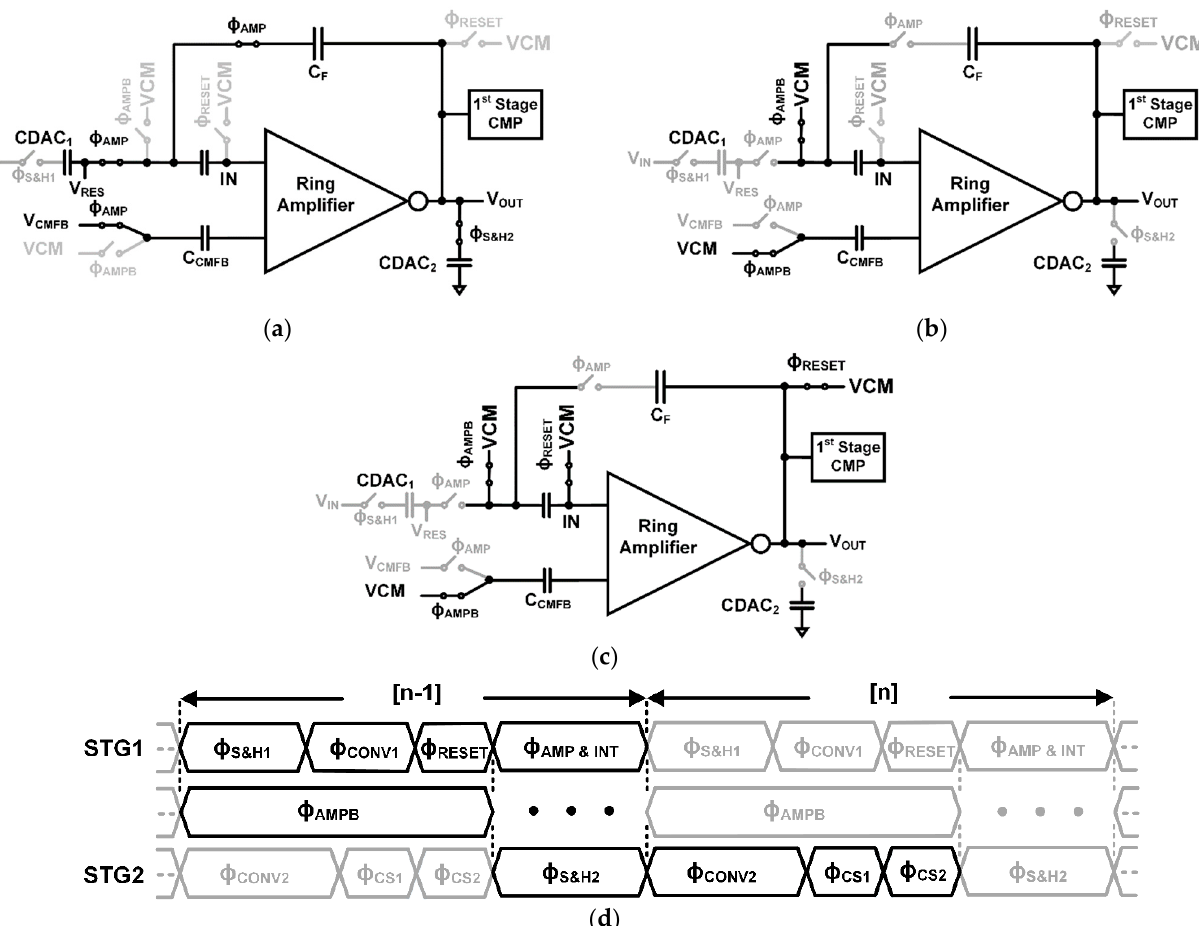
Figure 9. The ring amplifier-based integrator and its three phases of ( a ) amplification, ( b ) nonamplification without reset, and ( c ) nonamplification with reset; and ( d ) the operation timing diagram.